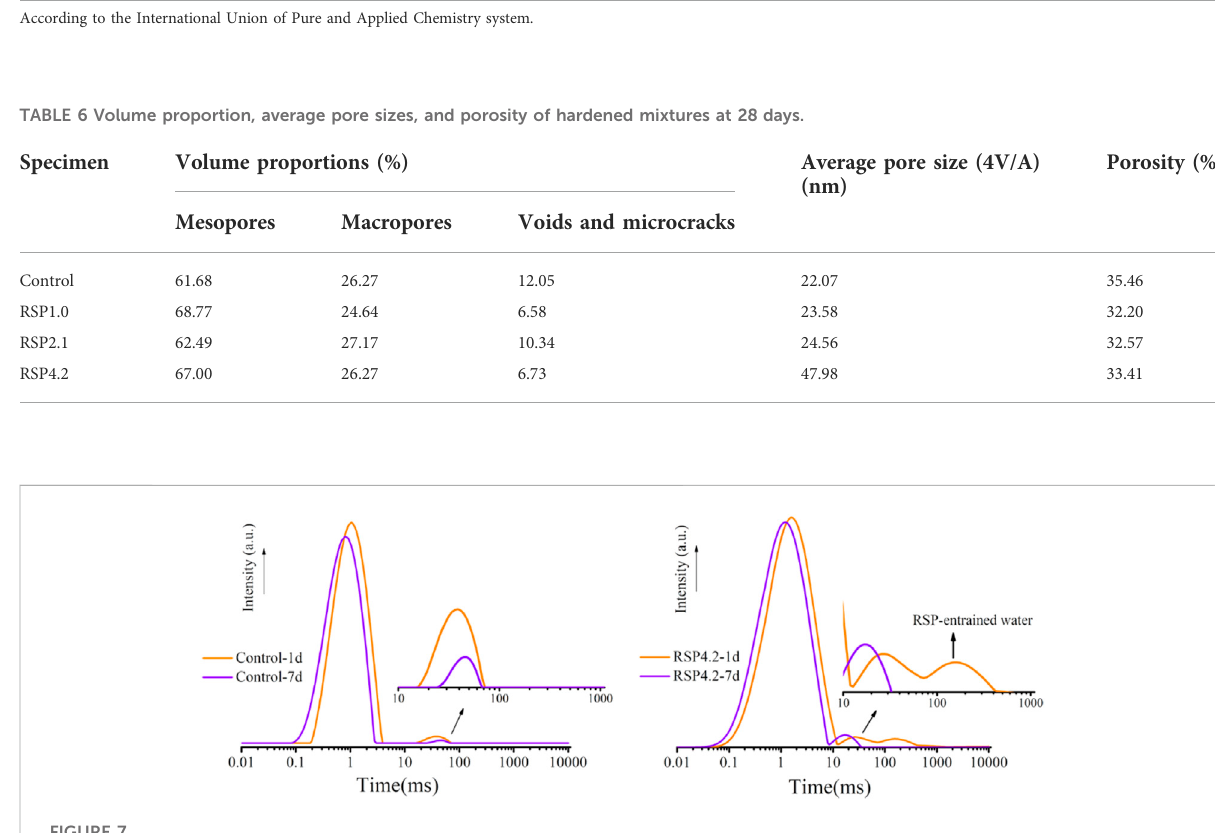
FIGURE 7 T 2 distributions of AAS mixtures with and without RSP for selected hydration